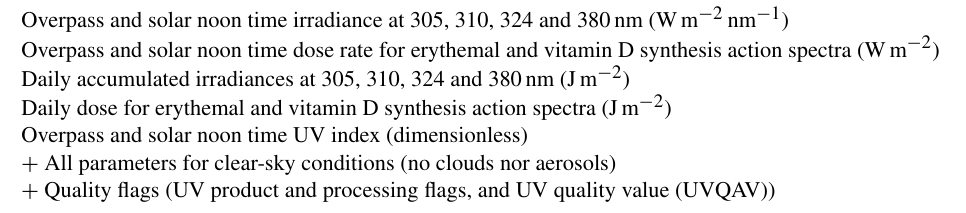
Table 1. TROPOMI surface UV parameters.